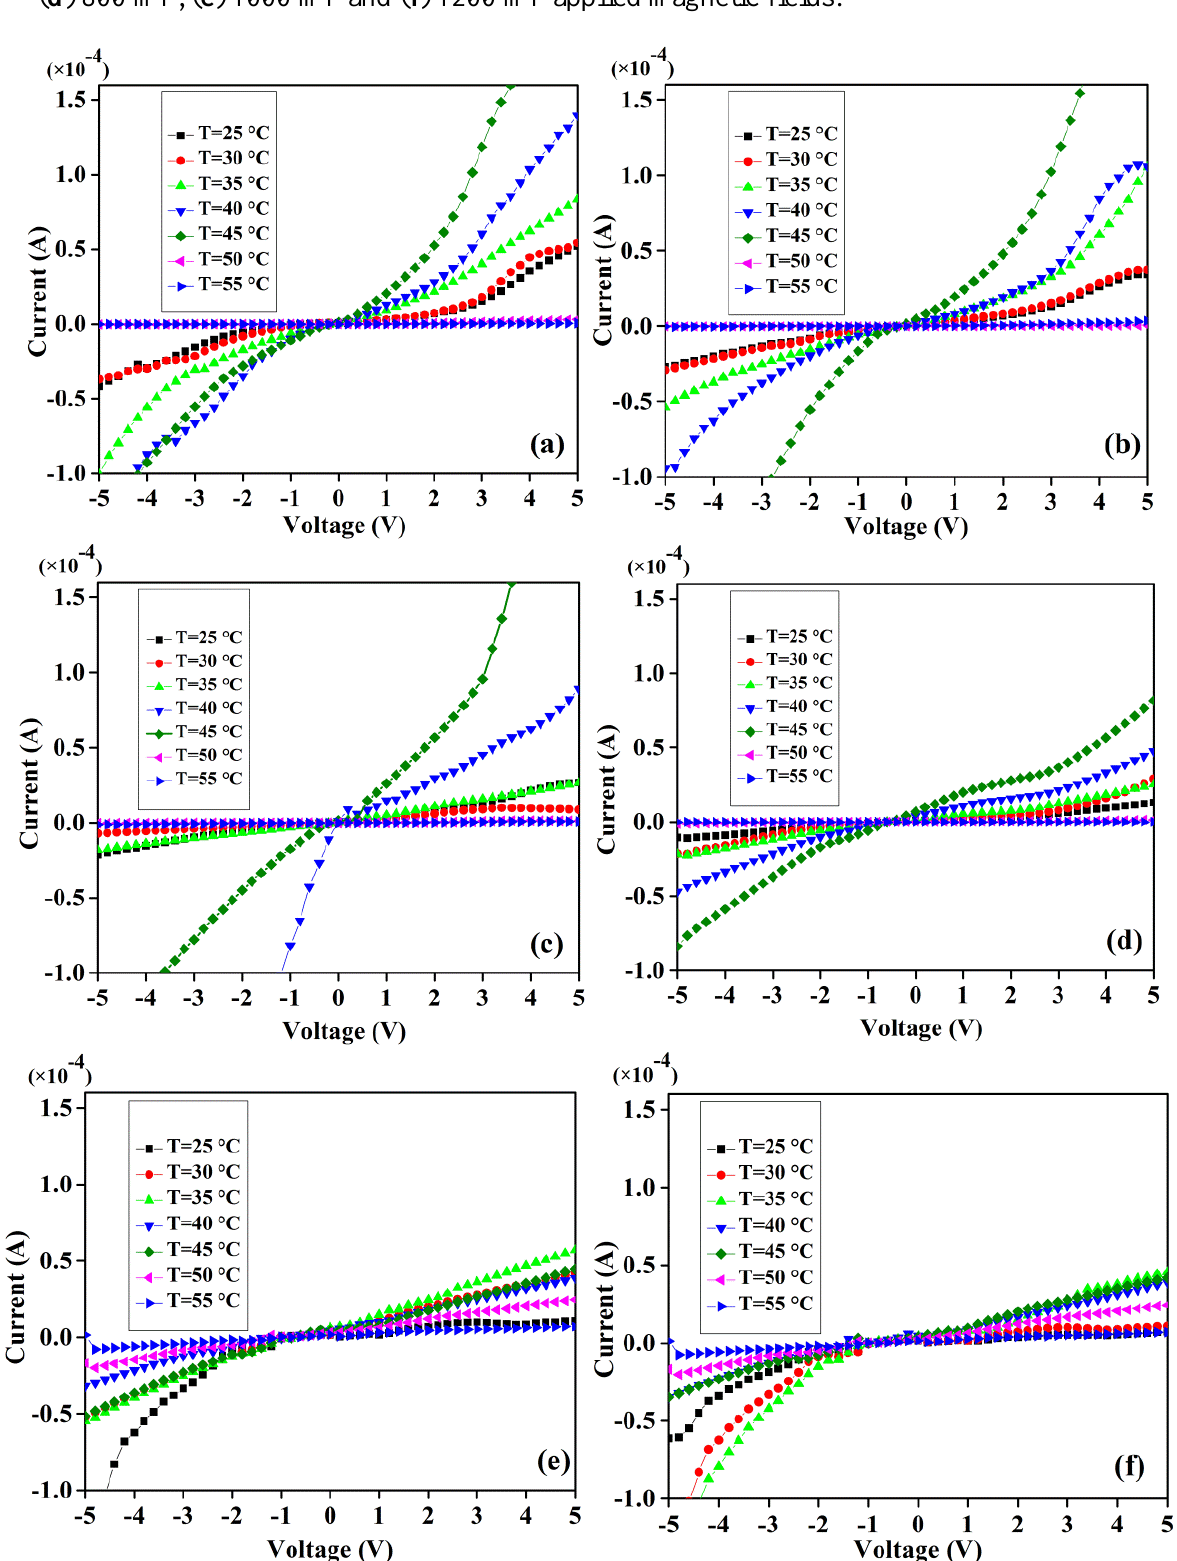
Figure 9. Temperature dependent I-V curves for: ( a ) 200 mT, ( b ) 400 mT, ( c ) 600 mT, ( d ) 800 mT, ( e ) 1000 mT and ( f ) 1200 mT applied magnetic